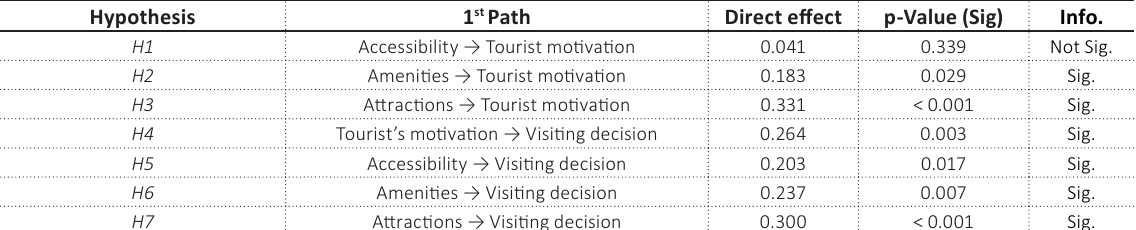
Table 3. First path result